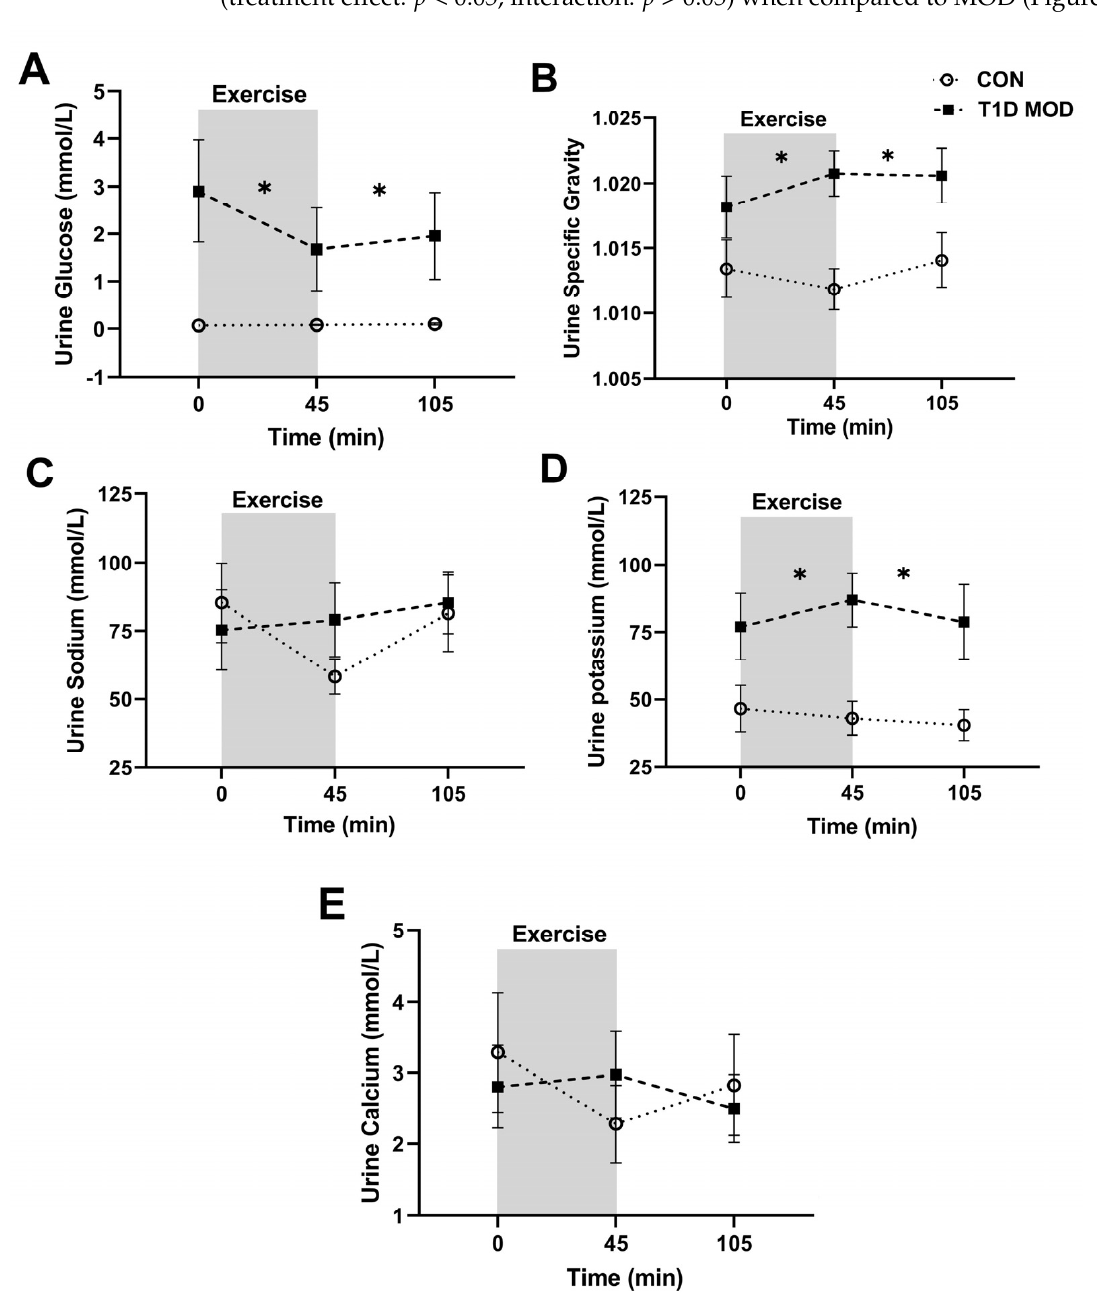
Figure 4. Urine concentration (mean ± SEM) of glucose ( A ), urine specific gravity ( B ), and urine concentrations of sodium ( C ), potassium ( D ), and calcium ( E ) before exercise (time 0), at the end of exercise (45 min), and at the end of the 60 min recovery (105 min) in CON (white circles) and T1D MOD (black squares). * shows significant differences (treatment effect) between CON and MOD from the beginning to the end of exercise and from the end of exercise to the end of recovery compared by ANOVA.